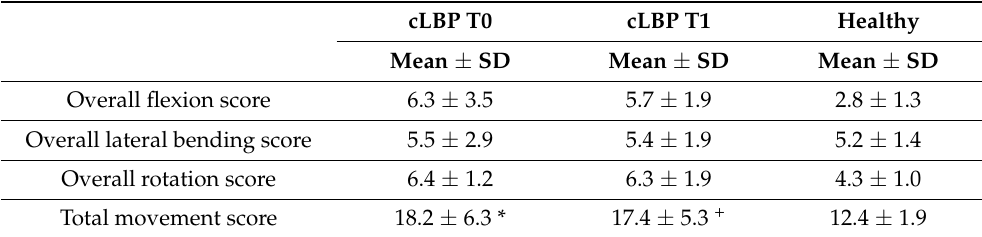
Table 5. Movement scores (overall and total) of participants with cLBP and healthy participants.